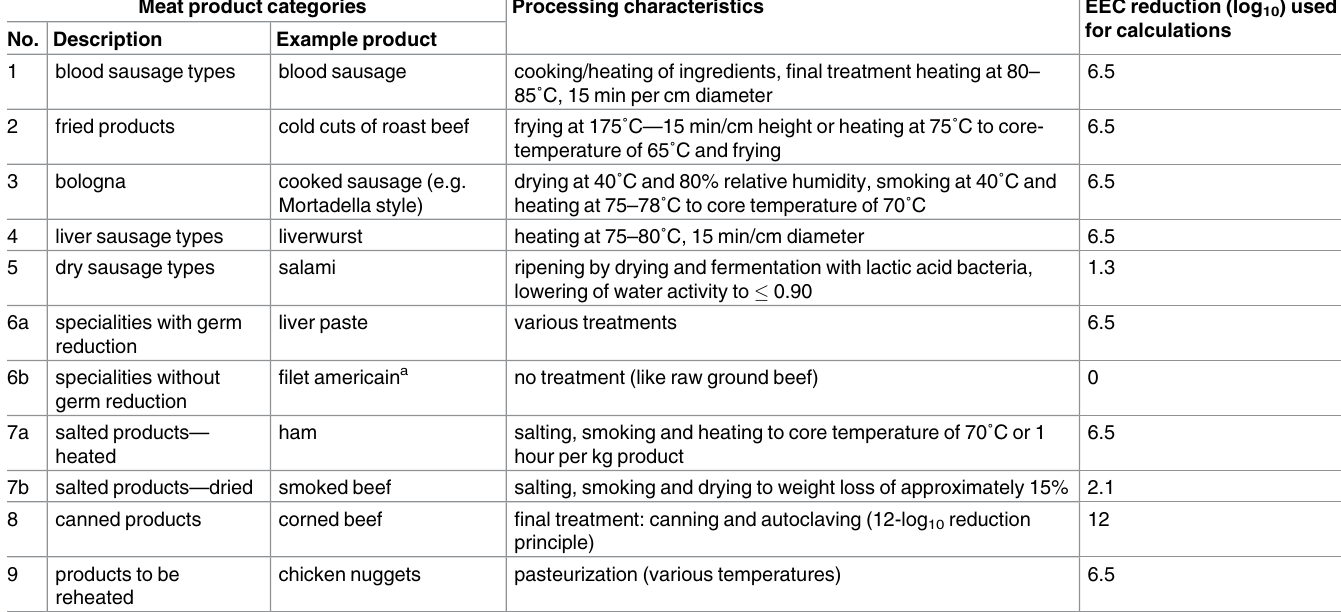
Table 2. Pre-retail